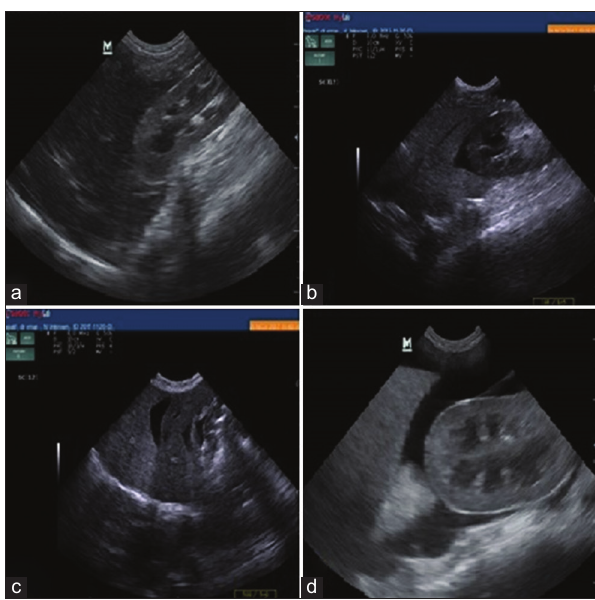
Figure-3: Ultrasonographic findings: (a) Decrease in hepatic echogenicity in comparison to renal cortex in dog with acute hepatitis. (b and d) Presence of clear anechoic ascites fluid separating right kidney and caudate liver lobe in dog with chronic hepatitis. (c) Increase in hepatic echogenicity than spleen echogenicity in dog with chronic hepatitis.